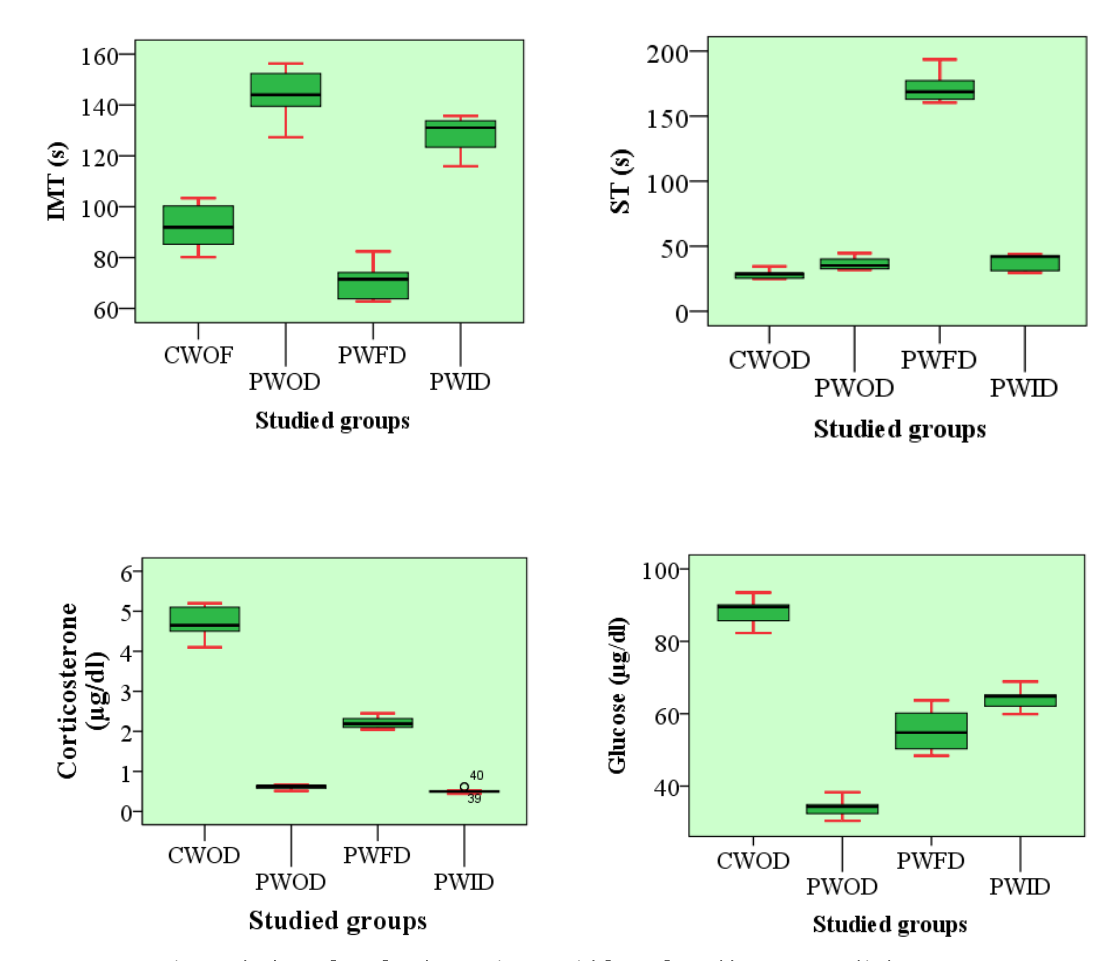
Fig. 3. The box plot related to various variable evaluated between studied groups